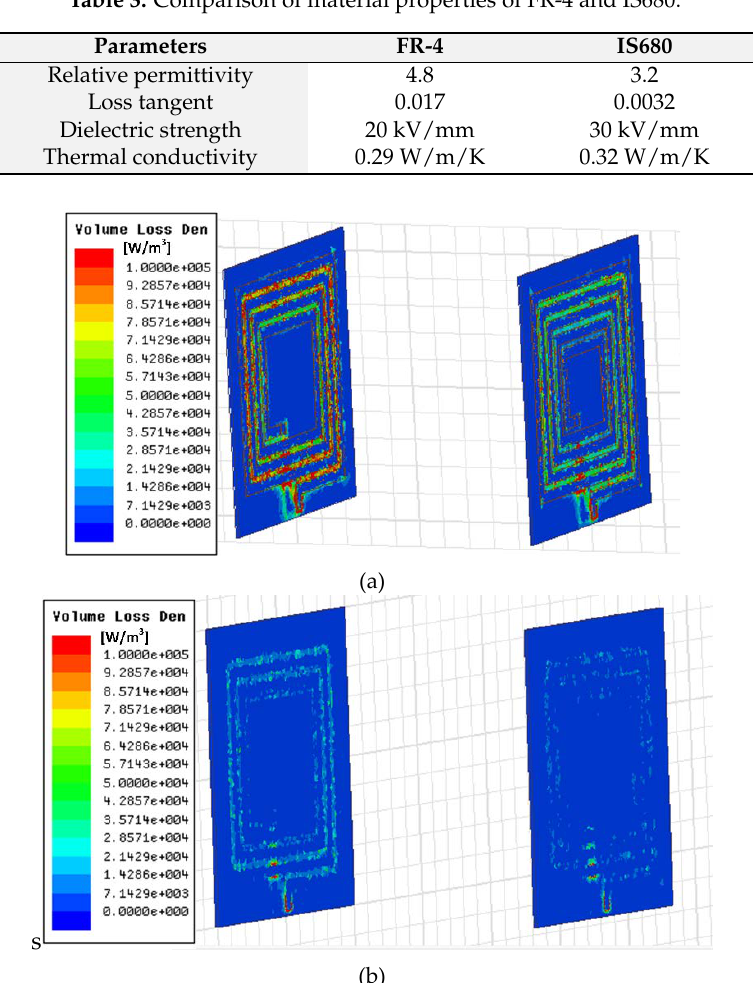
Figure 6. Configuration of the WPT system: ( a ) Dielectric loss density-FR4; ( b ) Dielectric loss